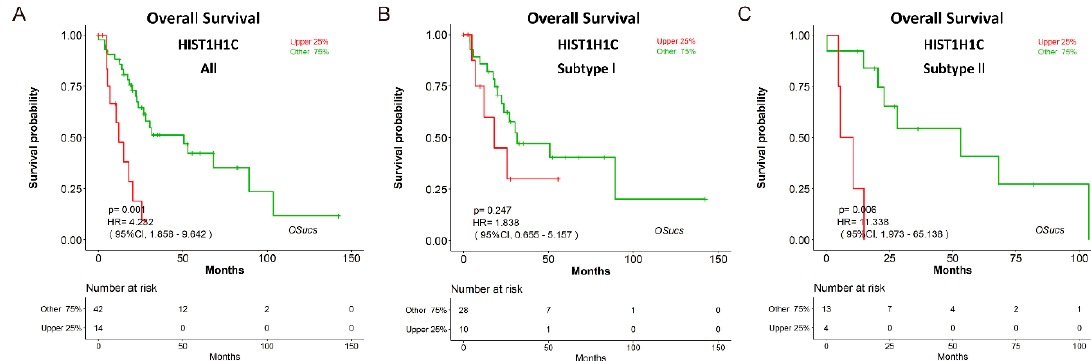
Figure 6. Evaluation of the prognostic value of histone cluster 1 H1 family member c (HIST1H1C) in OSucs. Kaplan-Meier plots for HIST1H1C in ( A ) All, ( B ) Subtype I, and ( C ) Subtype II UCS, respectively.